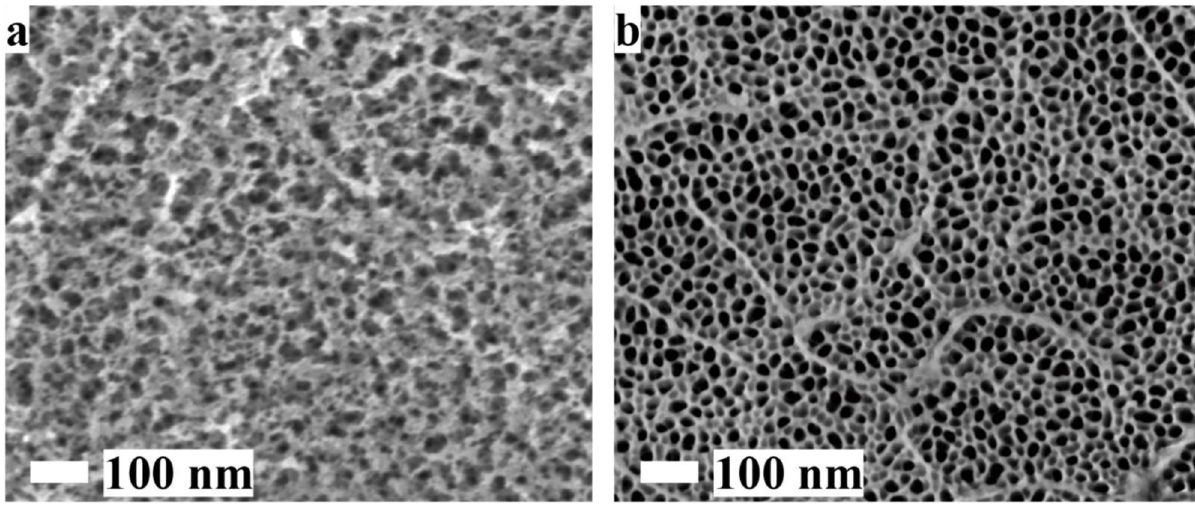
Fig. 1. SEM micrographs showing the surface porous features of (a) NMT1 and (b) NMT2.